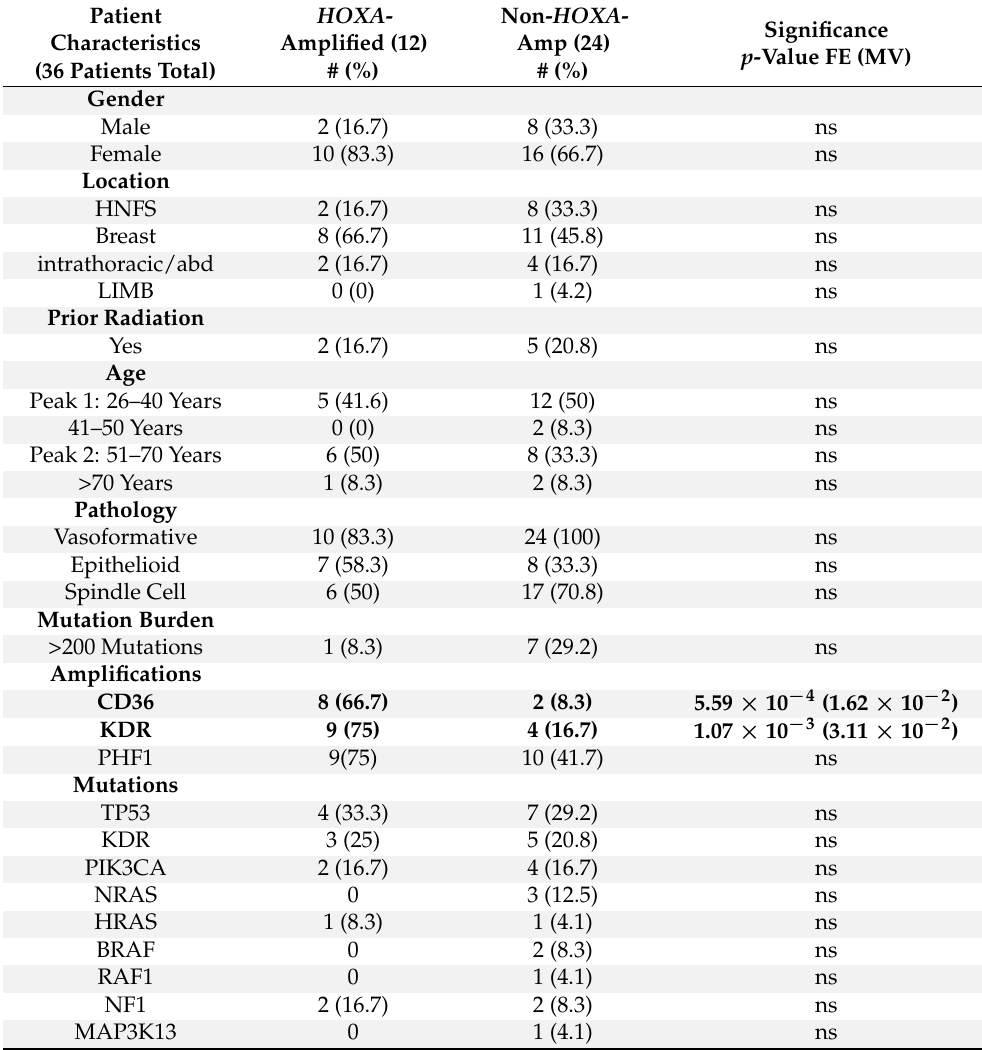
Table 1. Patient clinical characteristics and recurrent amplifications/mutation of HOXA -amplified and non- HOXA -amplified angiosarcomas. HOXA amplifications were significantly associated with amplifications of KDR and CD36 . There is also a non-statistically significant trend toward lower mutational burden and location in the breast versus HNSF. FE: fixed effect; MV: